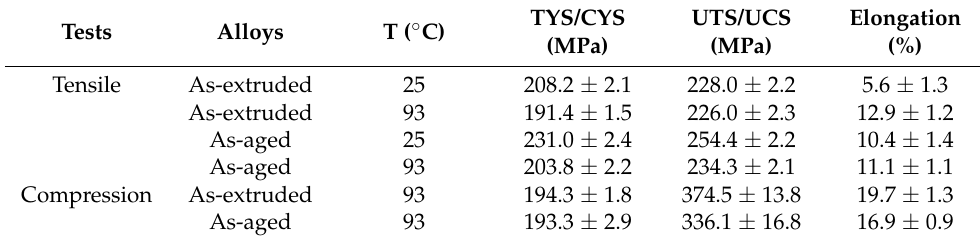
Table 2. Mechanical properties of the Mg–6.0Gd–1.2Cu–1.2Zr alloy at room temperature and 93 ◦